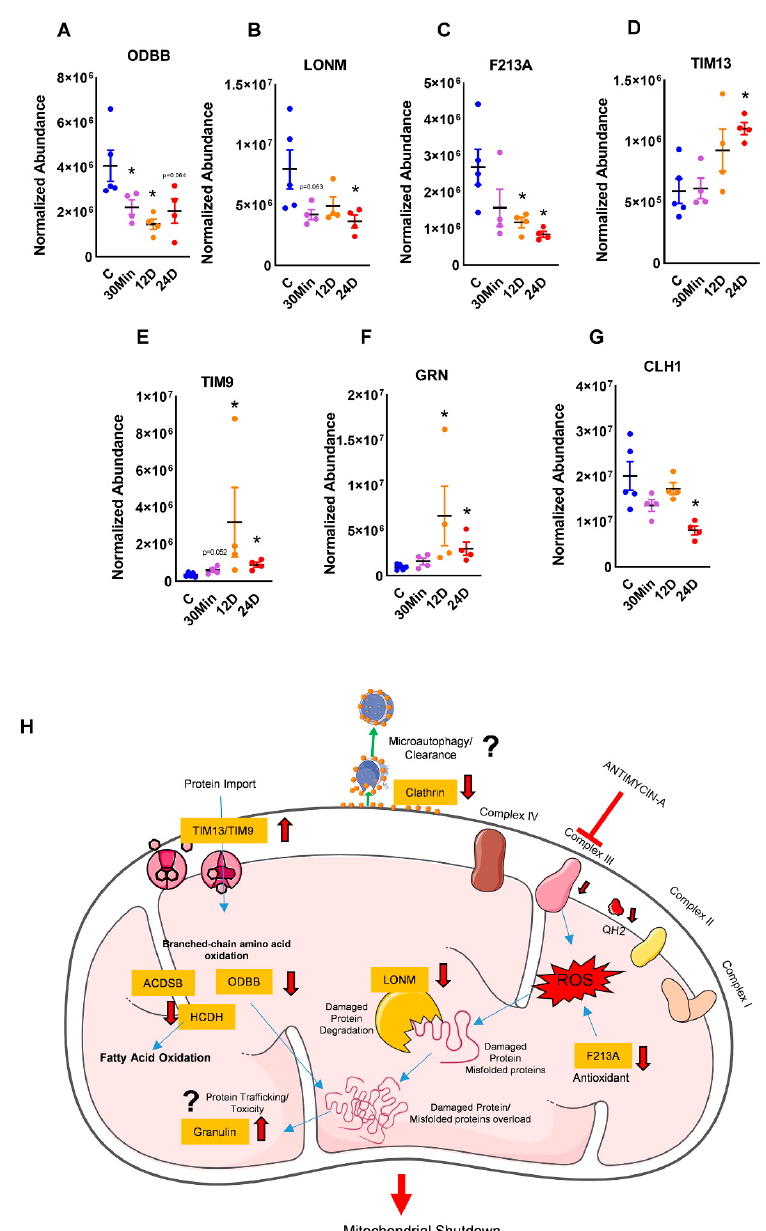
Figure 3. Complex III inhibition instigated dysfunctional protein metabolism and folding with oxidative stress. ( A ) 2-Oxoisovalerate dehydrogenase subunit beta (ODBB), a protein that metabolizes BCCAs or branched-chain amino acids, was found to be significantly downregulated in complex III-inhibited groups. ( B ) Lon protease homolog (LONM), a protein that repairs damaged polypeptides and ( C ) peroxiredoxin-like 2A (PRXL2A or F213A), an antioxidant protein, were found to be decreased in complex III-inhibited groups. ( D ) TIM13 and ( E ) TIM9 peptide transport proteins were significantly upregulated with complex III inhibition. ( F ) Granulin (GRN), a trafficking protein, and ( G ) clathrin (CLH1), a protein assisting microautophagy, were significantly decreased with complex III inhibition. ( H ) Decreased amino acid metabolism in conjunction with decreased protein repair and oxidative damage clearance would cause a toxic mitochondrial overload. This, in conjunction with increased inflammation and reduced microautophagy, could potentially shut down mitochondrial function. Red ‘T’ arrow shows inhibition, red arrows show downregulation and all other arrows show transfer (mean ± SEM, n = 4-5, * vs. 0h treatment, p < 0.05, t